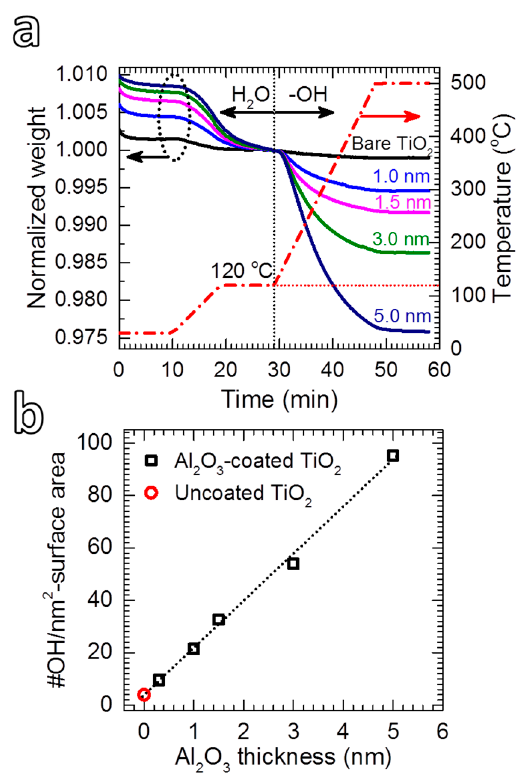
Figure 5. ( a ) TGA curves of uncoated and Al 2 O 3 -coated anatase TiO 2 powders and ( b ) the density of hydroxyl groups as a function of Al 2 O 3 thickness.